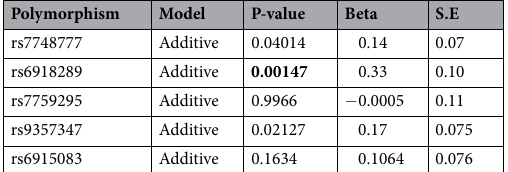
Table 4. Genetic association of the SNPs in TREM2 region with TNF- α levels in children of the SFS ( n = 139). P-value threshold is P < 0.01 . Significant p-values are highlighted in bold.